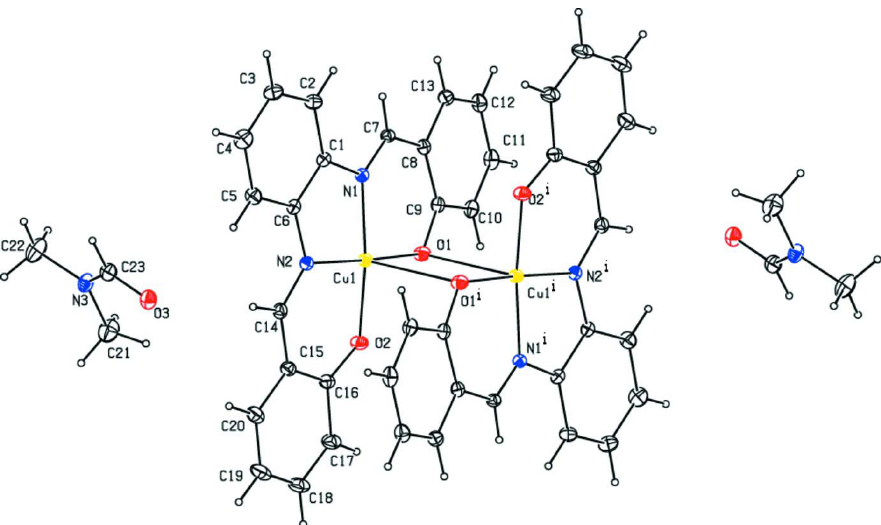
Figure 1 The molecular structure of (I), showing ellipsoids at the 50% probability level.